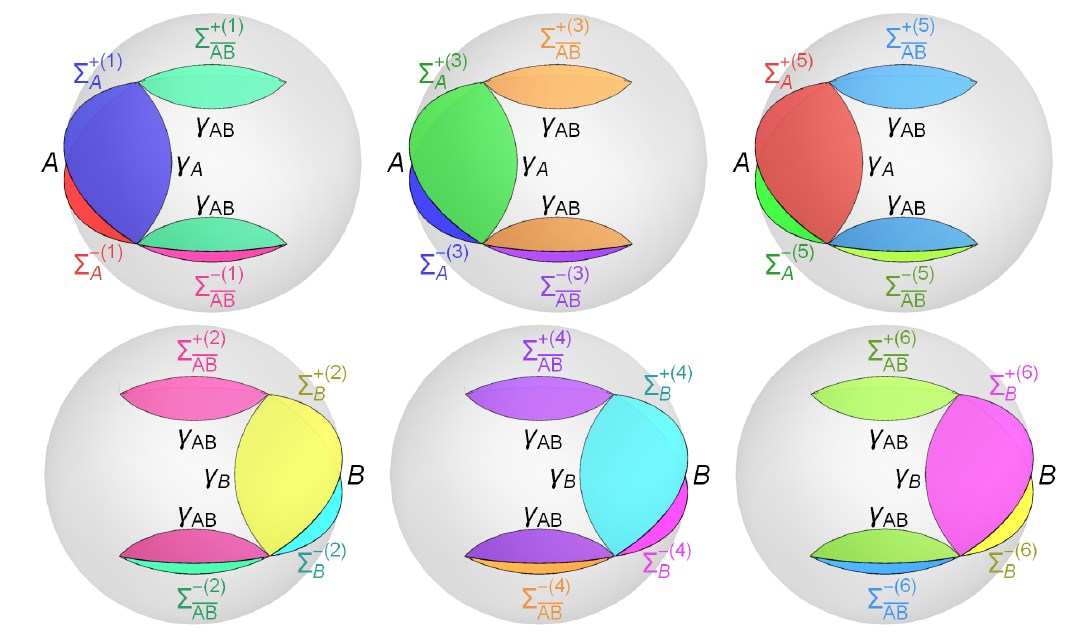
Figure 4 . The topology of a replica nonsymmetric saddle contributing to the holographic Rényi negativity N k for k = 6 . The 6 copies are first cut along Σ A , Σ B , Σ , and then the cut surfaces AB Σ ± ( i ) , Σ ± ( i ) , and Σ ± ( i ) with the same color are glued together (cyclically along Σ A in copies 1 , 3 , 5 , A B AB anti-cyclically along Σ B in copies 2 , 4 , 6 , and pairwise along Σ between copies 2 j − 1 and 2 j for AB j = 1 , . . . , 3 ). Note that the surface Σ shown here has two connected components on each AB